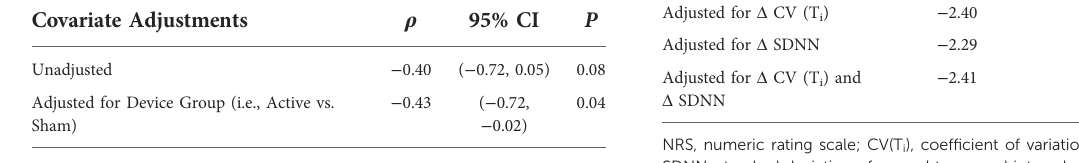
TABLE 2 Spearman correlations between Δ NRS pain and Δ SDNN.